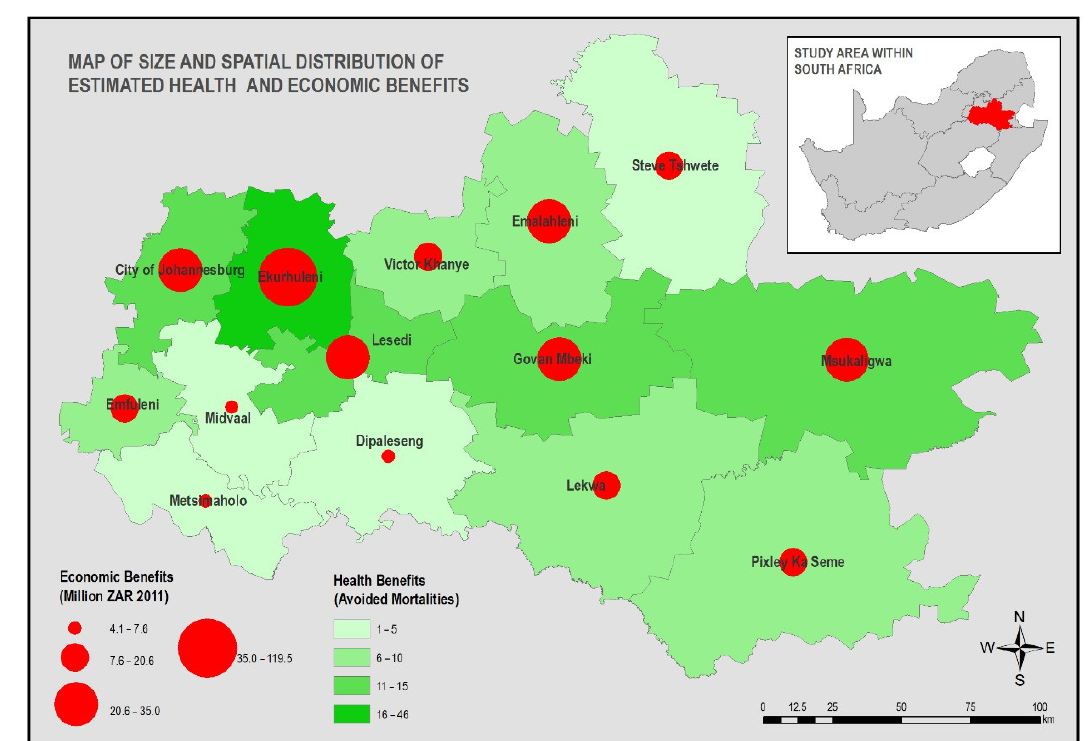
Figure 5. Size and spatial distribution of estimated health and economic